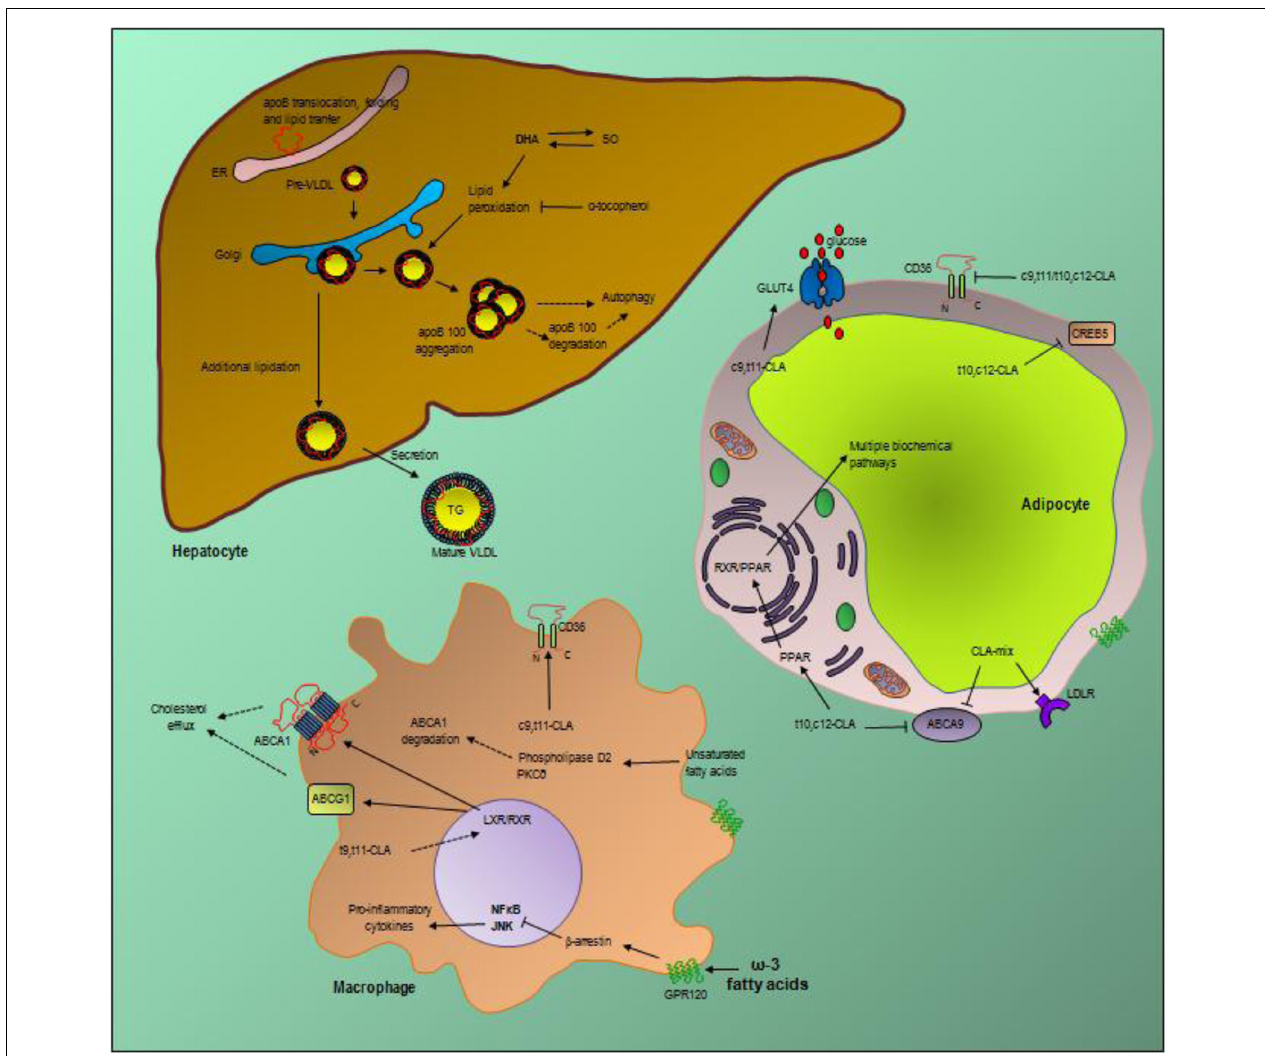
including DHA, activate GPR120 which through the β -arrestin pathway finally inhibit the NF κ B and JNK-induced pro-inflammatory cytokines secretion.The specific isomer trans -9, trans -11 of conjugated linoleic acid (t9, t11 CLA) is proposed to activate the nuclear receptor liver X receptor (LXR) and induce cellular cholesterol efflux by increasing the expression of the ATP-binding cassette transporters ABCA1 and ABCG1. Certain unsaturated fatty acids degrade ABCA1 protein through the phospholipase D2 and protein kinase C delta (PKC δ ) pathway.The isomer cis -9, trans -11-CLA induce the scavenger receptor CD36 expression in macrophages and repress its expression in adipocytes. In adipocytes different CLA isomers have been proposed to induce the expression of the low density lipoprotein receptor (LDLR) or the glucose transporter type 4 (GLUT4) and repress the expression of CD36, cAMP responsive element binding protein 5 (CREB5) or ABCA9. CLA effects through the transcription factor peroxisome proliferator activated receptors (PPARs) which trigger multiple biochemical pathways have also been